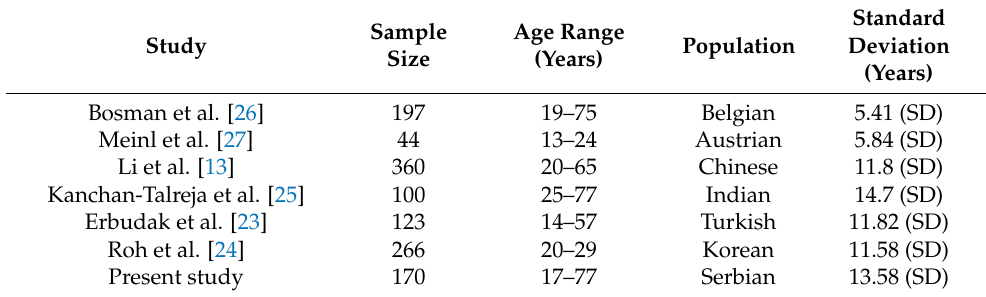
Table 8. Authors who applied Kvaal’s method to different populations—comparison of the obtained standard